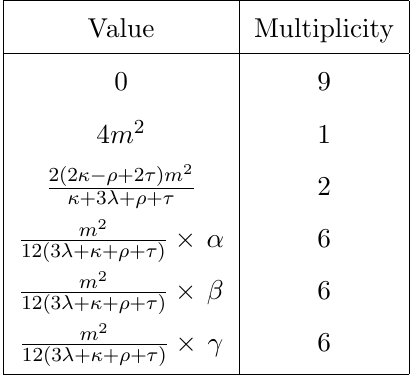
Table 9 . Scalar mass eigenstates for the SSB pattern SU(3) ! T 7 using a 15 of